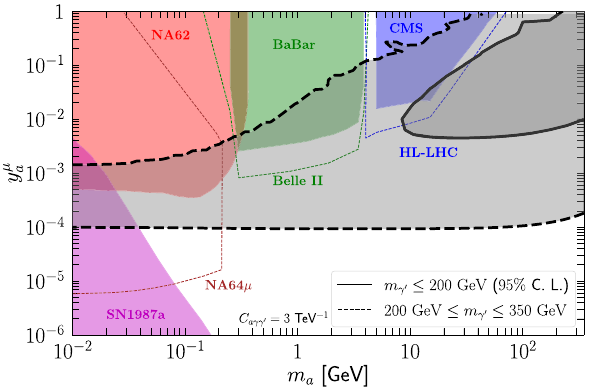
Fig. 4 Experimental constraints on the dark photon kinetic mixing parameter (cid:7) as a function of the dark photon mass m γ (cid:3) from: (1) elec- tron anomalous magnetic moment ( g − 2 ) e (purple) [46]; (2) resonant productionofdarkphotonattheBaBarexperiment(green)[73];(3)dark photon from pion decay at the NA48 experiment (red) [74]; (4) dark photon production from various mesons at LHCb [75,76] and Higgs at CMS (blue) [77]; (5) electroweak precision observables (yellow) [78]. The hashed band is the allowed region for explaining the muon g-2 with dark photon alone while the black contour is obtained together with dark axion portal at 95%